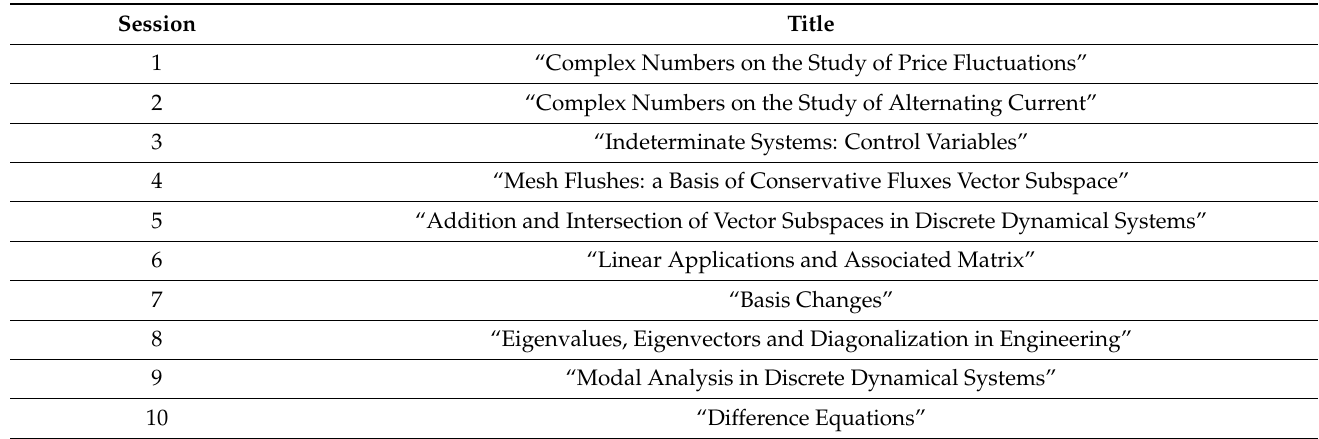
Table 2. Applications of mathematics in engineering I: linear algebra.